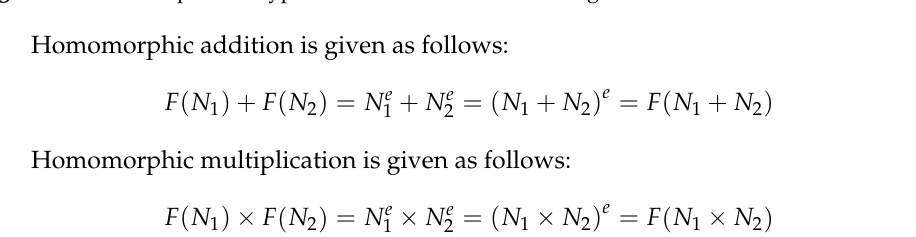
Figure 2. Homomorphic encryption framework for data storage.